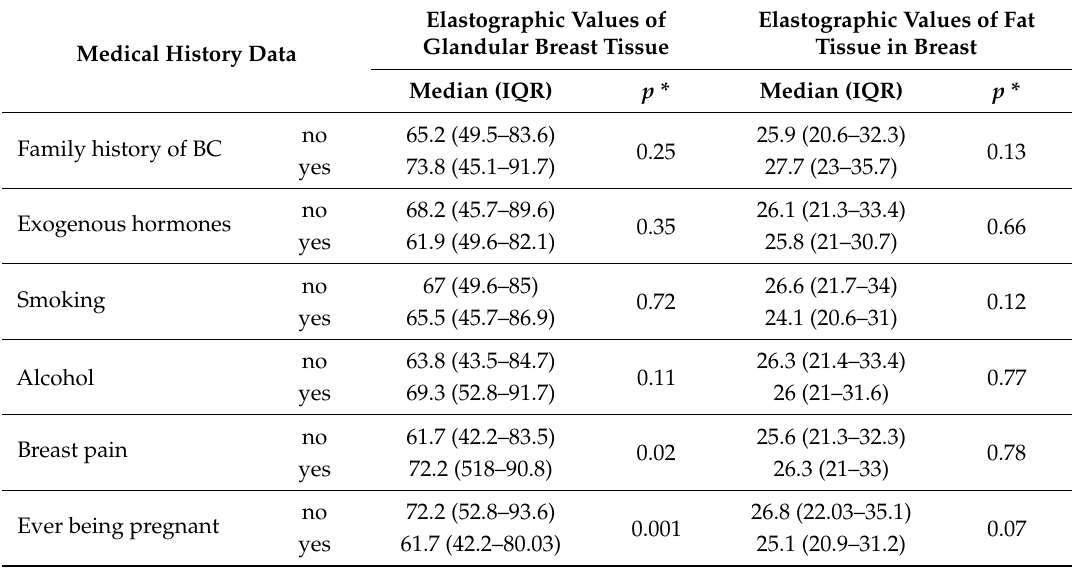
Table 5. Elastographic values of glandular and fat tissue to data obtained from medical history. Elastographic Values of Elastographic Values of Glandular Breast Tissue Medical History Data